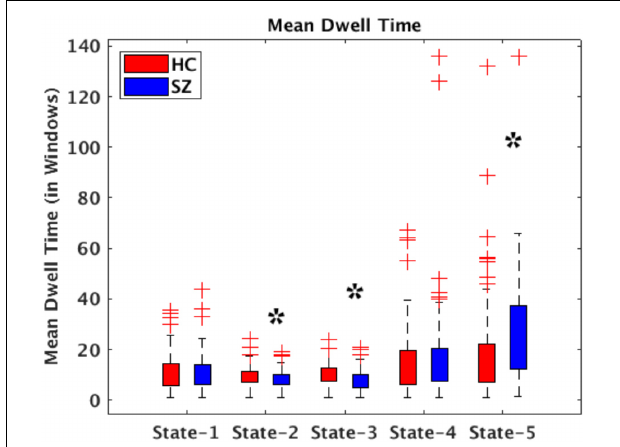
FIGURE 6 | Bar plots displaying mean dwell times in States 1–5 for HC (red) and SZ (blue) participants. The states showing significant differences between the HC and SZ groups are marked with a black star (FDR-corrected results). The two test t - and p -values are listed in Table 1 .